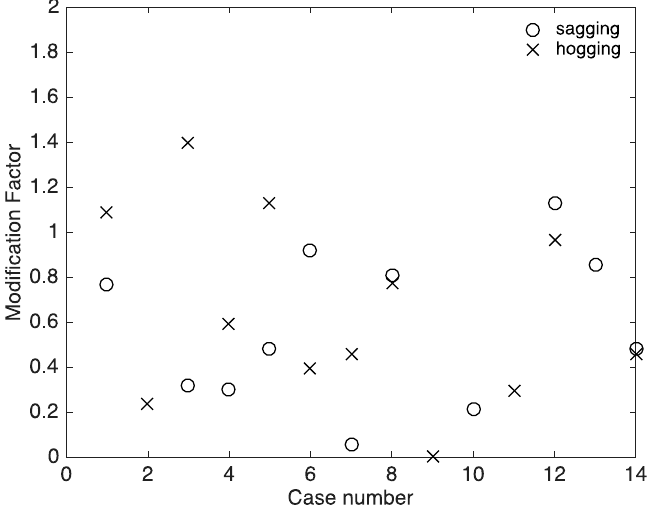
Figure 5. MT-InSAR-based building modification factors.